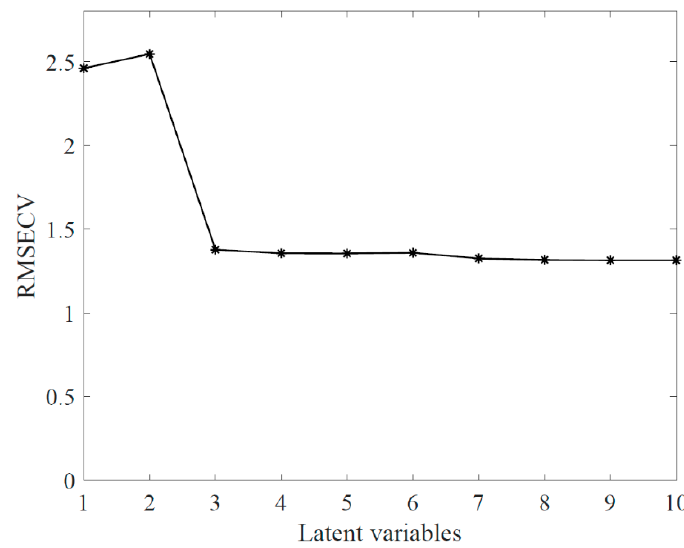
Figure 3. Latent variable selection using the root mean square error of cross-validation.